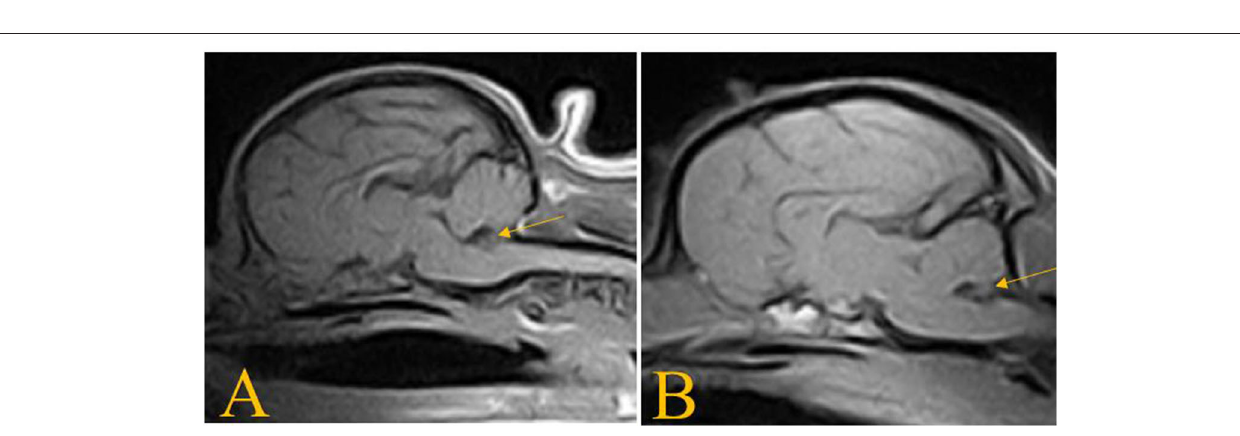
FIGURE 4 | T1W sagittal images of the dogs in case 2 (A) and case 3 (B) showing absence of the nodulus